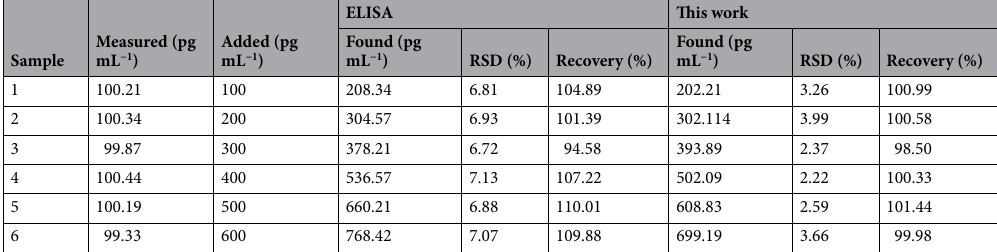
Table 1. Comparison of determination for SPOP levels by two